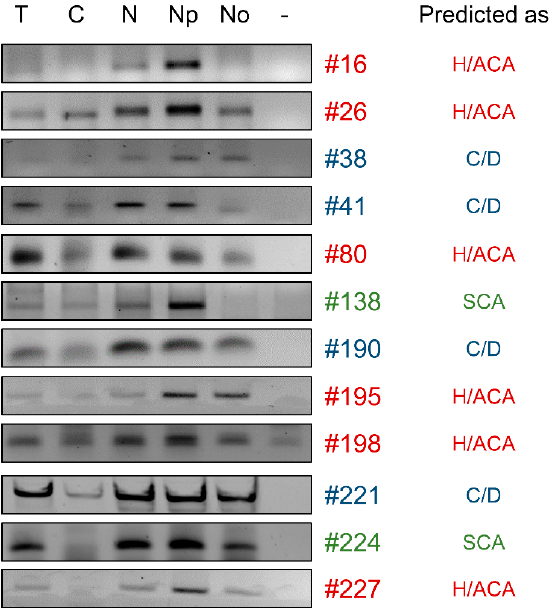
Figure 3. Accumulation of snoRNA candidates in nucleoli. Isolation of the nucleoli by sucrose cushion centrifugation was performed as described in the Material and Methods section. Then, total RNA from each fraction was extracted and localization of snoRNA candidates (#) was assessed by RT-PCR. The class of snoRNA (H/ACA, C/D or SCA) predicted by the webservers is indicated on the right. T, total fraction; C, cytoplasmic fraction; N, nuclear fraction; Np, nucleoplasmic fraction; No, nucleolar fraction; -, mock PCR.